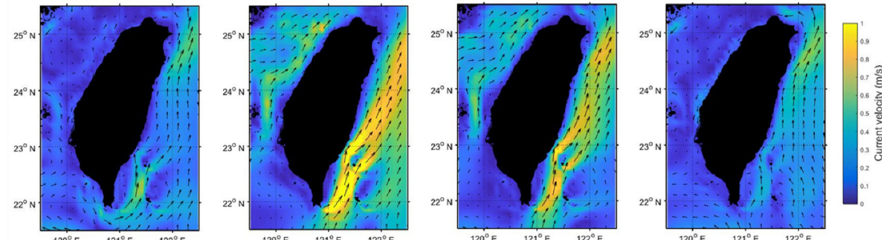
Figure 4. Spatial distributions of environmental variables (used in MaxEnt habitat model) by season within study area from 2015 to 2018.